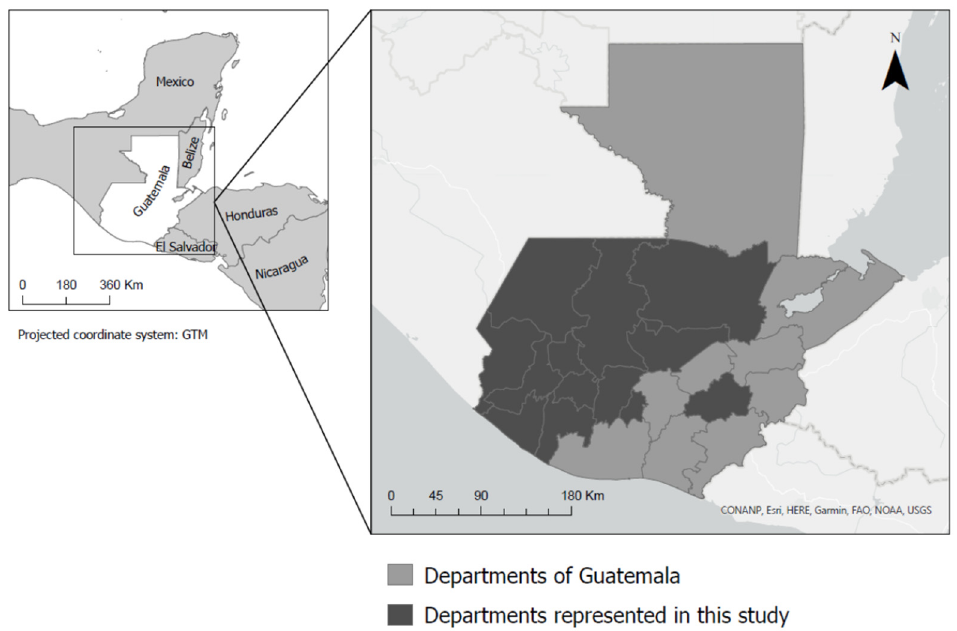
Figure 2. Guatemalan departments included within respondents’ geographical areas of professional influence. GIS layers source: UN Office for the Coordination of Humanitarian Affairs—Field Information Services.